Question: Write a single sentence explaining what this figure depicts.
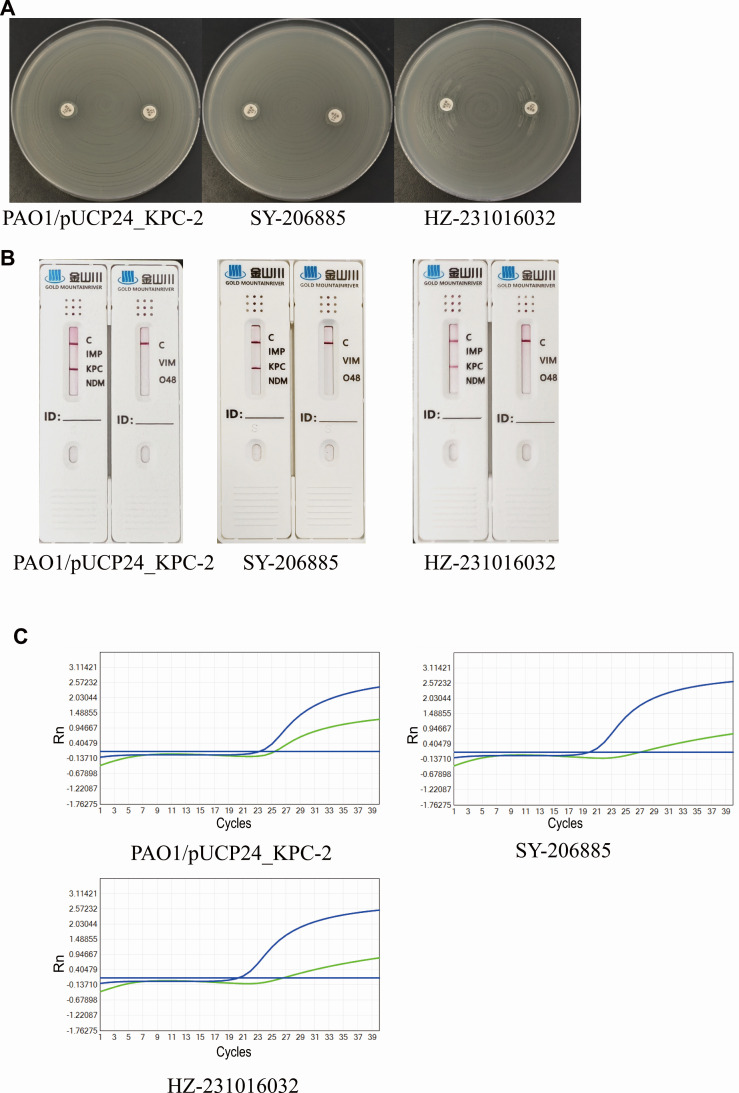
Answer: Phenotypic and molecular detection of KPC-71 and KPC-78. ( A ) Modified carbapenem inactivation method showing the inhibition zones produced by the indicator strain. A reduced or absent inhibition zone indicates carbapenem inactivation by the test isolate and is interpreted as a positive result for carbapenemase production. ( B ) NG-Test Carba for detecting KPC-71 and KPC-78. The appearance of both the control line ( C ) and the KPC line indicates a positive result for KPC carbapenemase, whereas no signal was observed for VIM, NDM, IMP, or OXA-48. ( C ) qPCR amplification curves for bla KPC detection. Positive amplification curves were observed in PAO1/pUCP24_KPC-2, SY-206885, and HZ-231016032, confirming the presence of bla KPC variants in these strains.